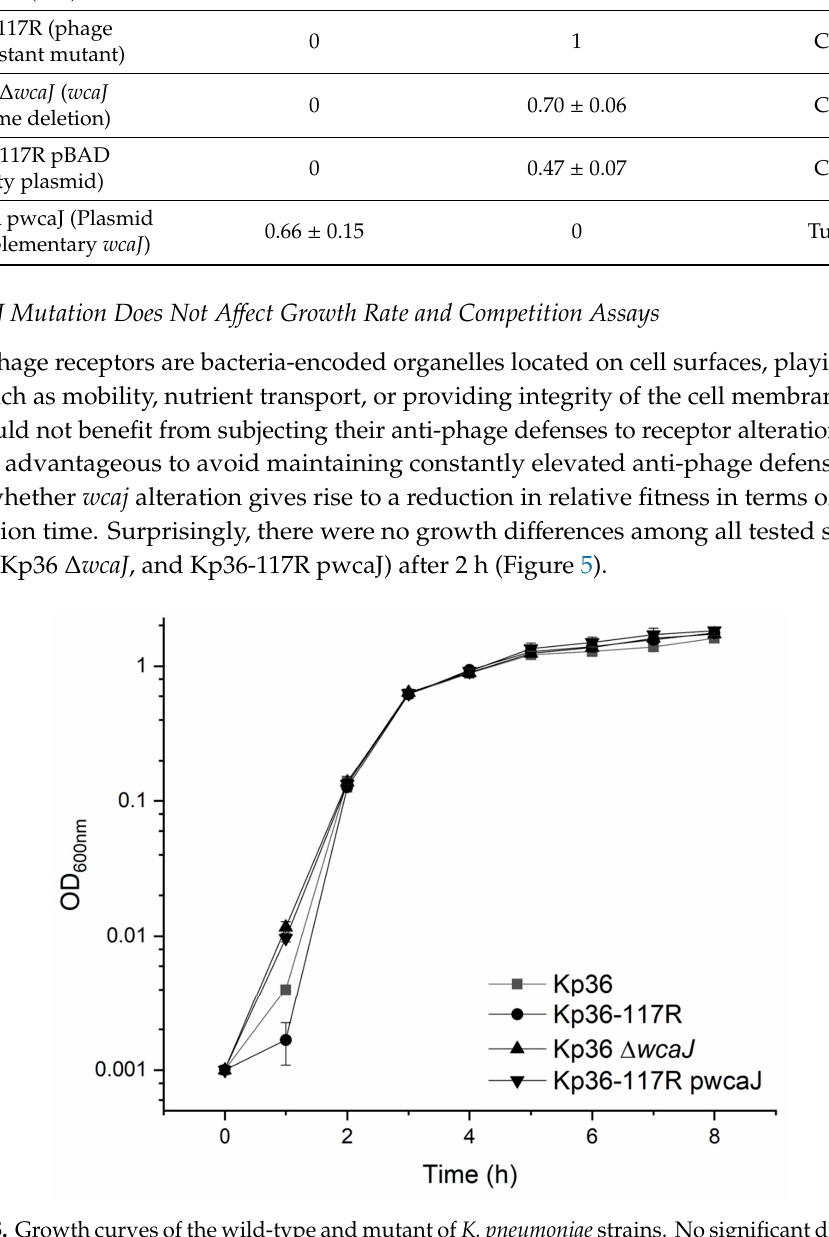
Figure 5. Growth curves of the wild-type and mutant of K. pneumoniae strains. No significant di ff erences were observed among the parental K. pneumoniae strain Kp36 and its derivative mutants (Kp36-117R, Kp36 ∆ wcaJ , and Kp36-117R pwcaJ) after 2 h. Optical densities (OD 600 ) were measured at 1 h intervals over an 8 h period of incubation at 37 ◦ C in LB broth with aeration. For strain Kp36-117R pwcaJ, media was supplemented with apramycin (100 µ g / mL) and 0.4% L-arabinose. Error bars represent standard errors from the experiment performed in triplicate.